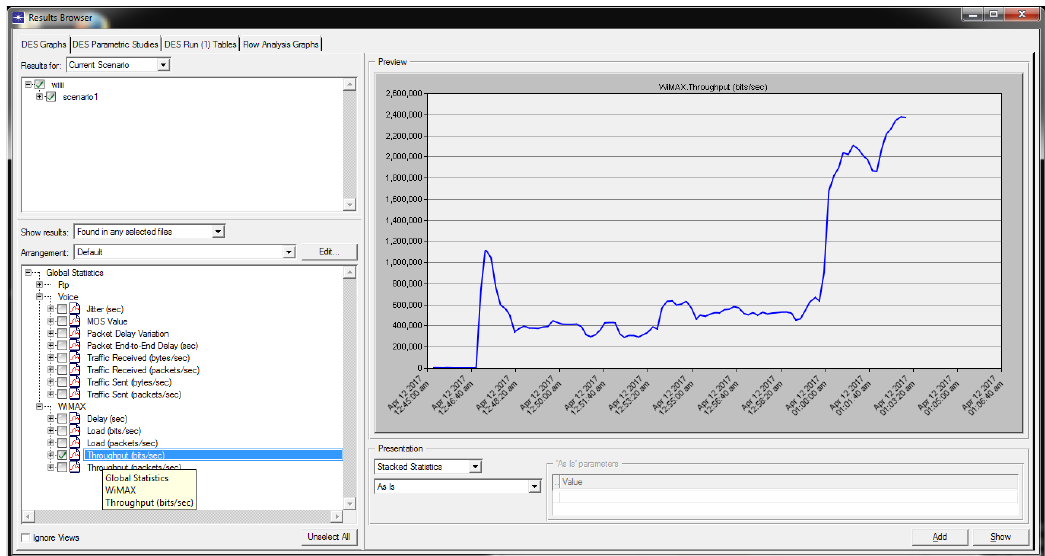
Fig. 3. Global Statistics WiMax throughput bits/second for overall network, reaches 2400000 (2.4Gbps) bit per second